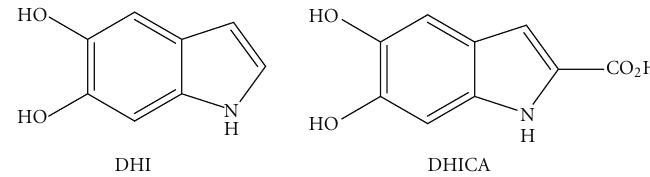
Figure 1: Precursors of the melanin oligomers.